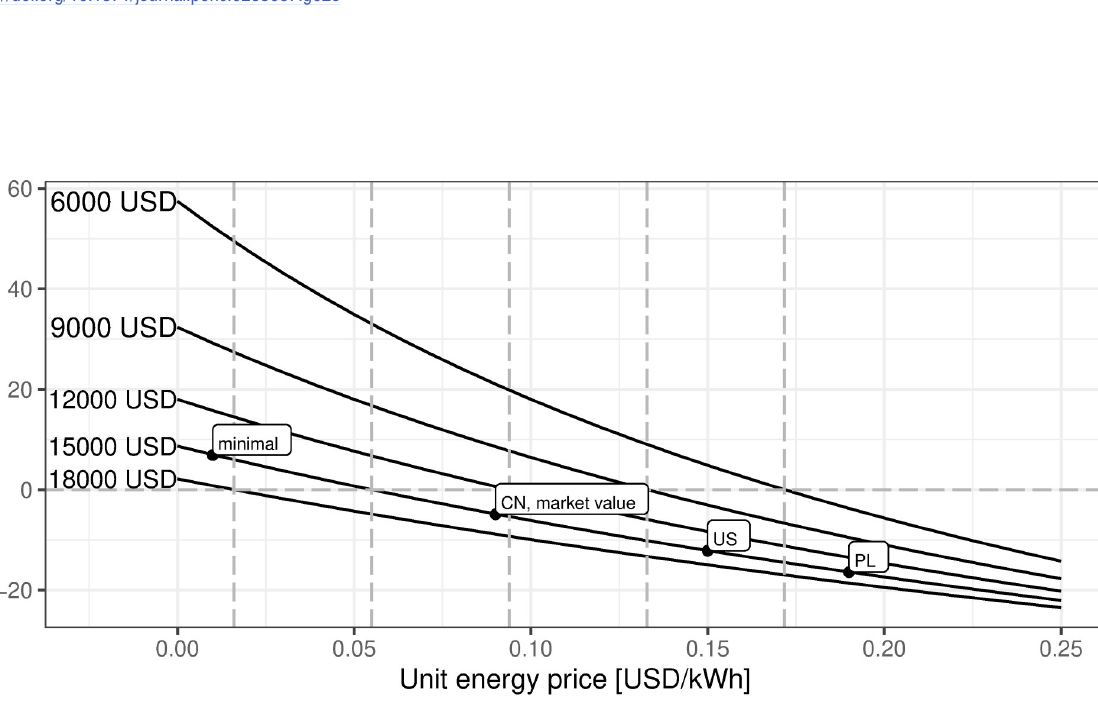
PLOS ONE | https://doi.org/10.1371/journal.pone.0283687 March 30,